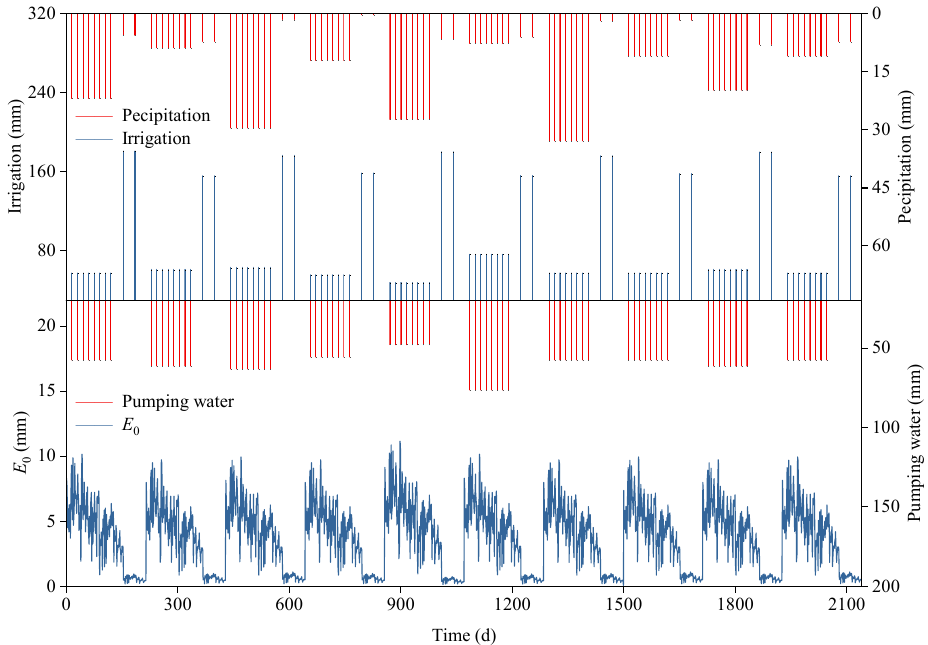
Figure 2. Source and sink terms of case 1, including irrigation and precipitation and pumping water and the water surface evaporation ( E 0 ).